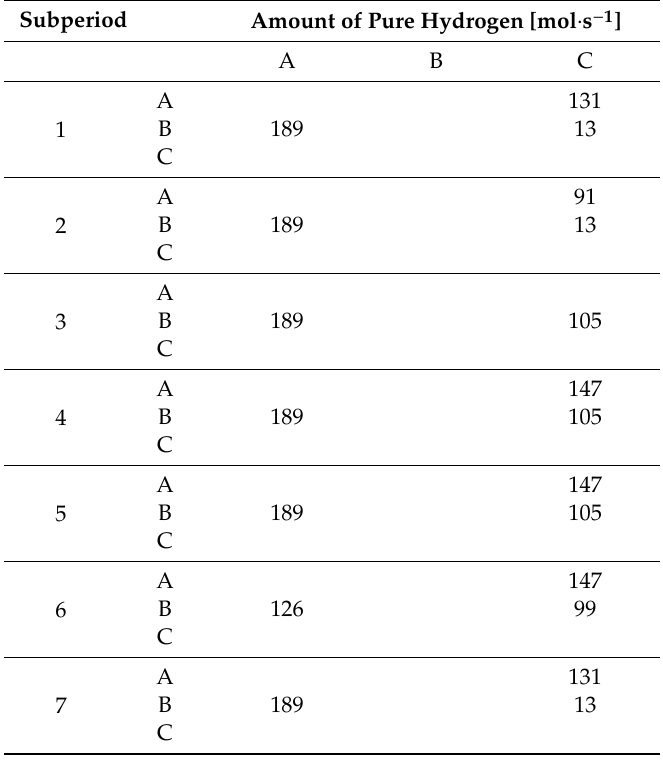
Table 6. The amount of hydrogen exchange among the plants in the proposed